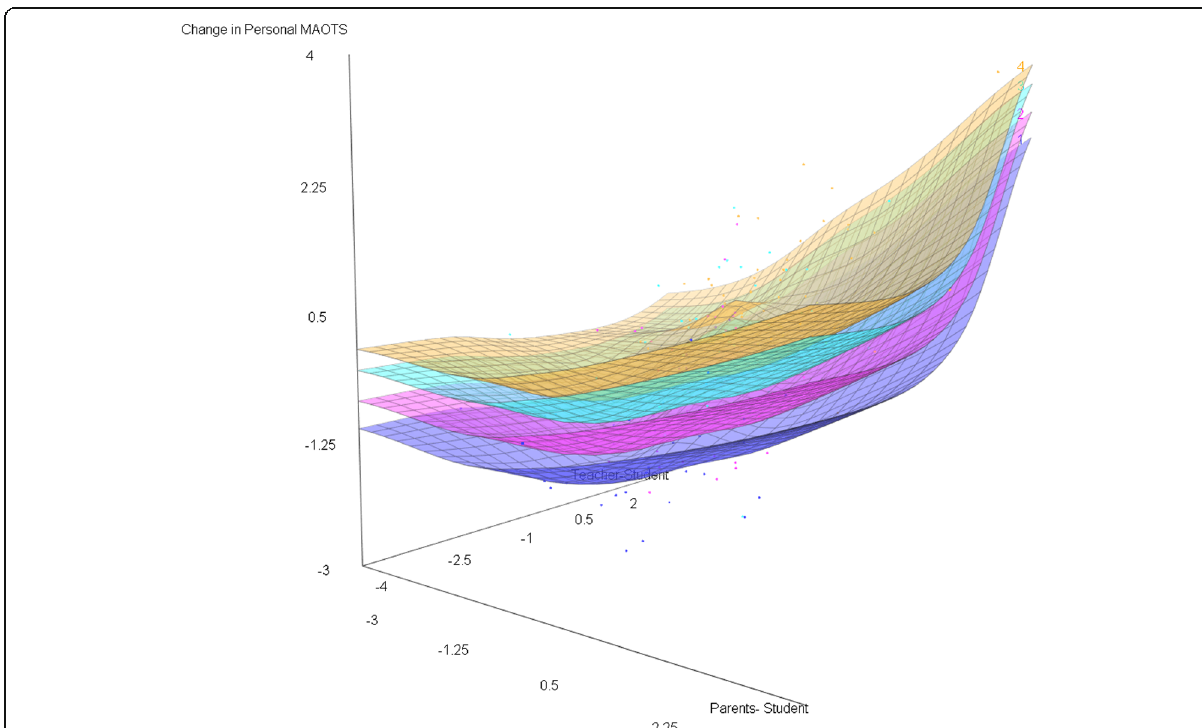
Fig. 3 Changes to boys ’ personal MAOTS vs. differences between perceived environmental emphases on MAOTS and personal MAOTS